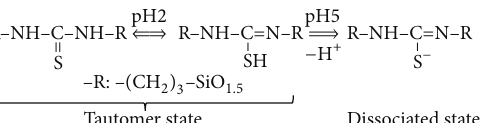
Scheme 2: Representation of molecular model structures of tau- tomer and dissociated